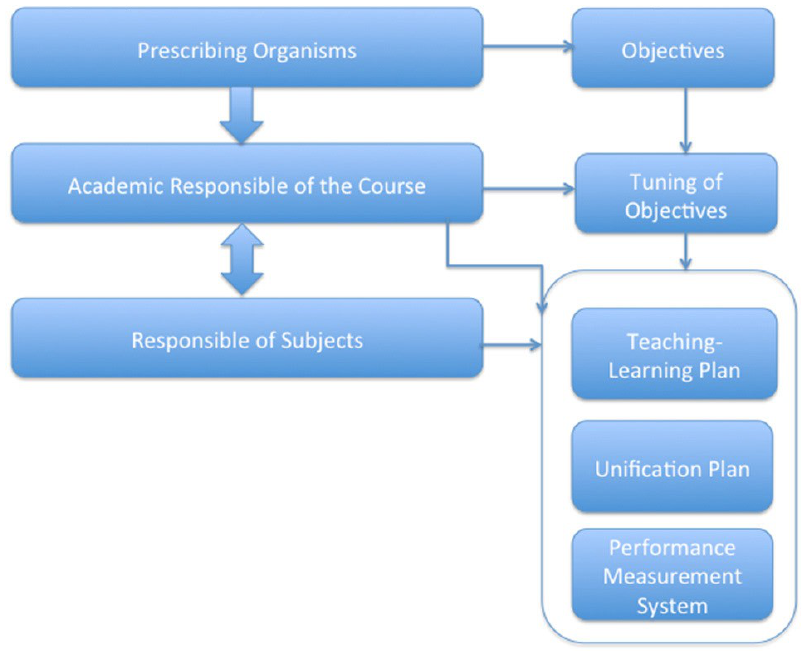
Figure 3. TELETCO